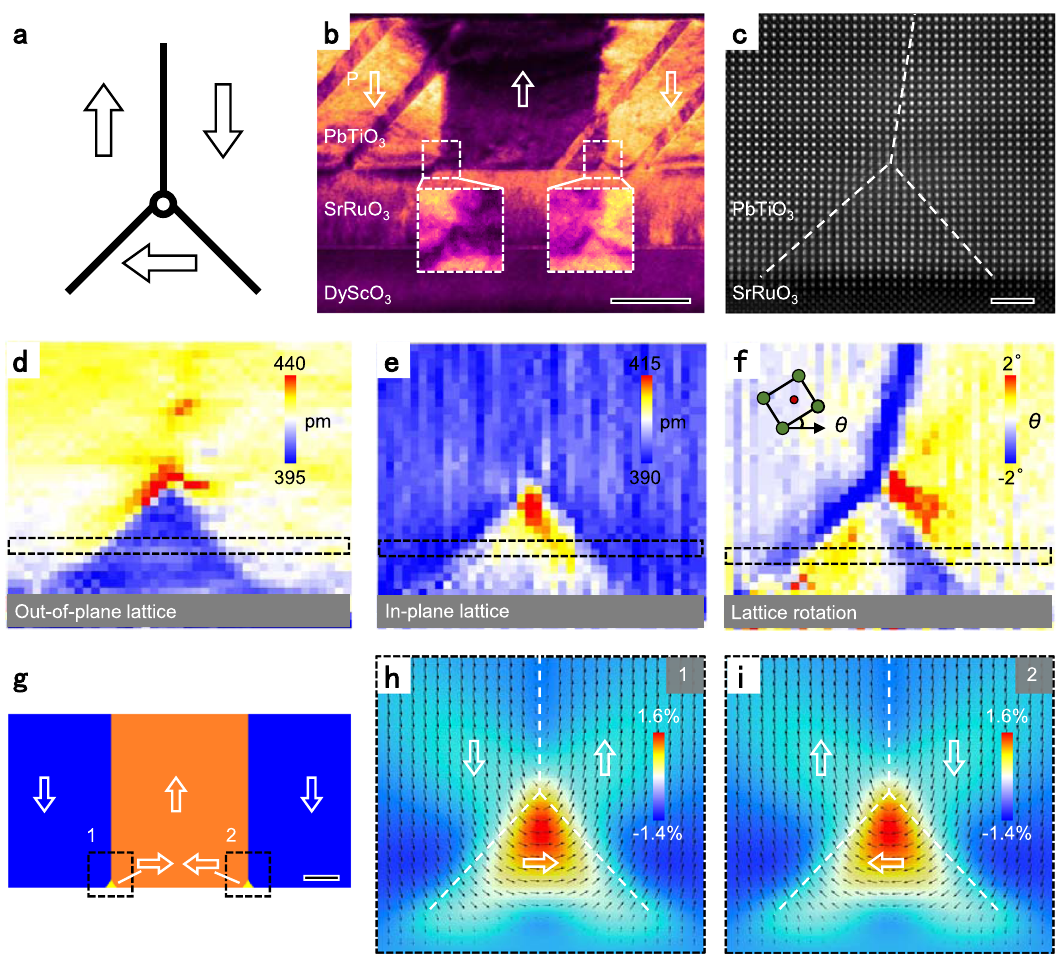
Fig. 1 | Threefold vertices at the PbTiO 3 /SrRuO 3 interface. a Schematic diagram of a single threefold vertex. Arrows indicate directions of polarization. b A cross- sectional dark- fi eld TEM image with g =(101) showing the domain structure in the PbTiO 3 fi lm. The insets show the enlarged view of threefold vertices. Scale bar, 50nm. c AnatomicallyresolvedHAADFimageofanisolatedthreefoldvertexatthe PbTiO 3 /SrTiO 3 interface. White dashed lines indicate 180° and 90° domain walls. Scale bar, 2nm. d – f Maps of out-of-plane lattice parameters ( d ), in-plane lattice